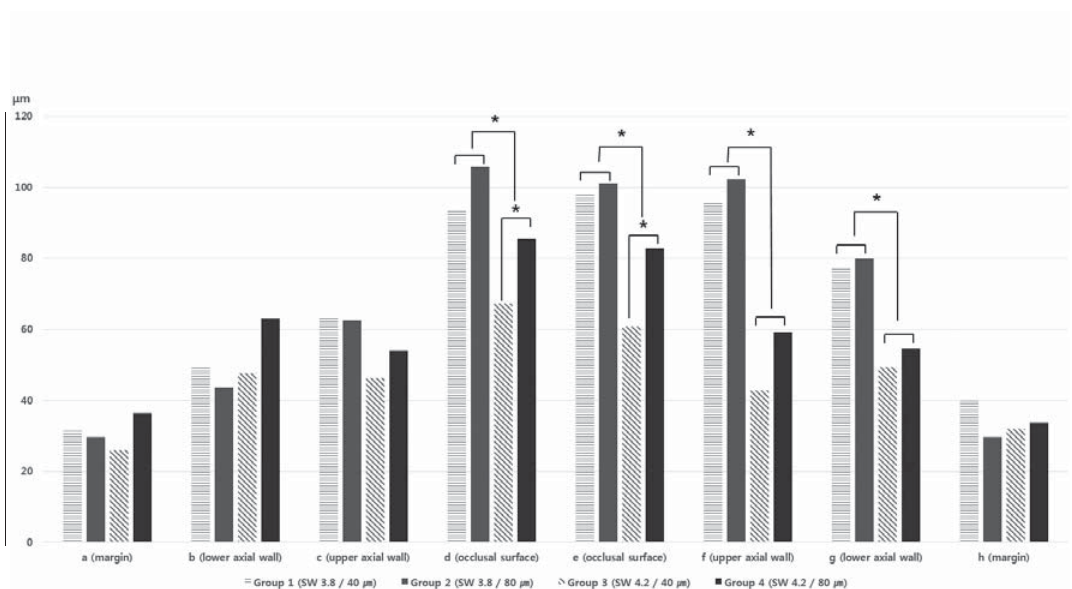
Figure 8- (cid:3) (cid:48)(cid:72)(cid:68)(cid:81)(cid:3) (cid:76)(cid:81)(cid:87)(cid:72)(cid:85)(cid:81)(cid:68)(cid:79)(cid:3) (cid:191)(cid:87)(cid:3) (cid:11) (cid:80) m) of each measuring points on mesiodistally sectioned surface. *indicates statistically (cid:86)(cid:76)(cid:74)(cid:81)(cid:76)(cid:191)(cid:70)(cid:68)(cid:81)(cid:87)(cid:3)(cid:71)(cid:76)(cid:73)(cid:73)(cid:72)(cid:85)(cid:72)(cid:81)(cid:70)(cid:72)(cid:86)